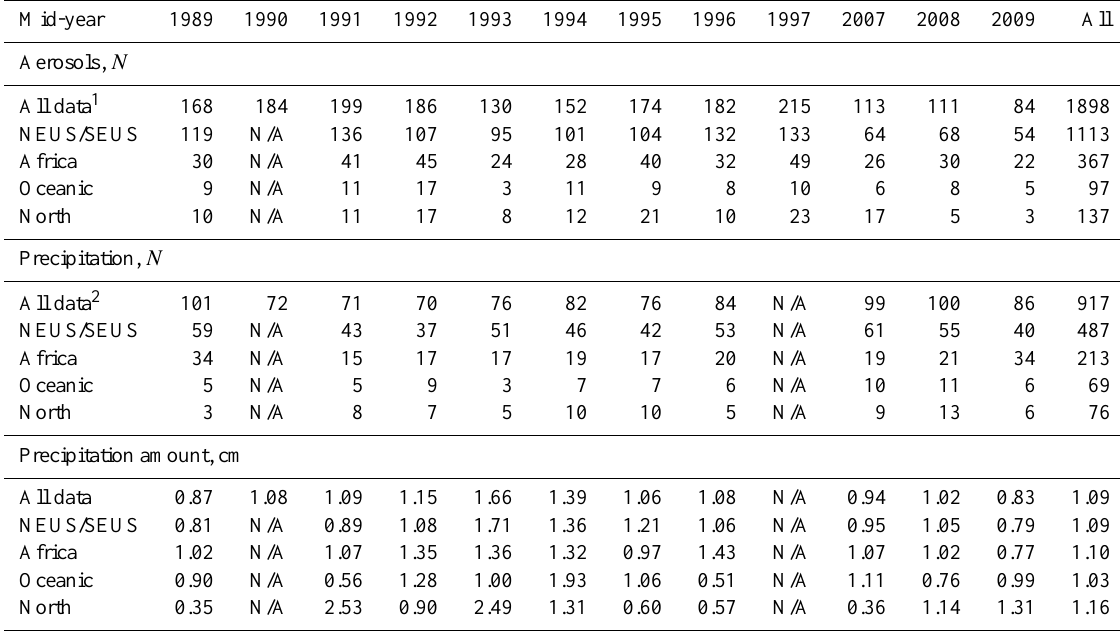
Table 1. Numbers ( N ) of daily aerosol and precipitation samples and mean precipitation amounts (cm) per sample for all data evaluated in this study partitioned by flow regime and year. Annual data from 1989 to 1997 are binned by calendar year (1 January–31 December) and those from 2006 to 2009 are binned from 1 July to 30